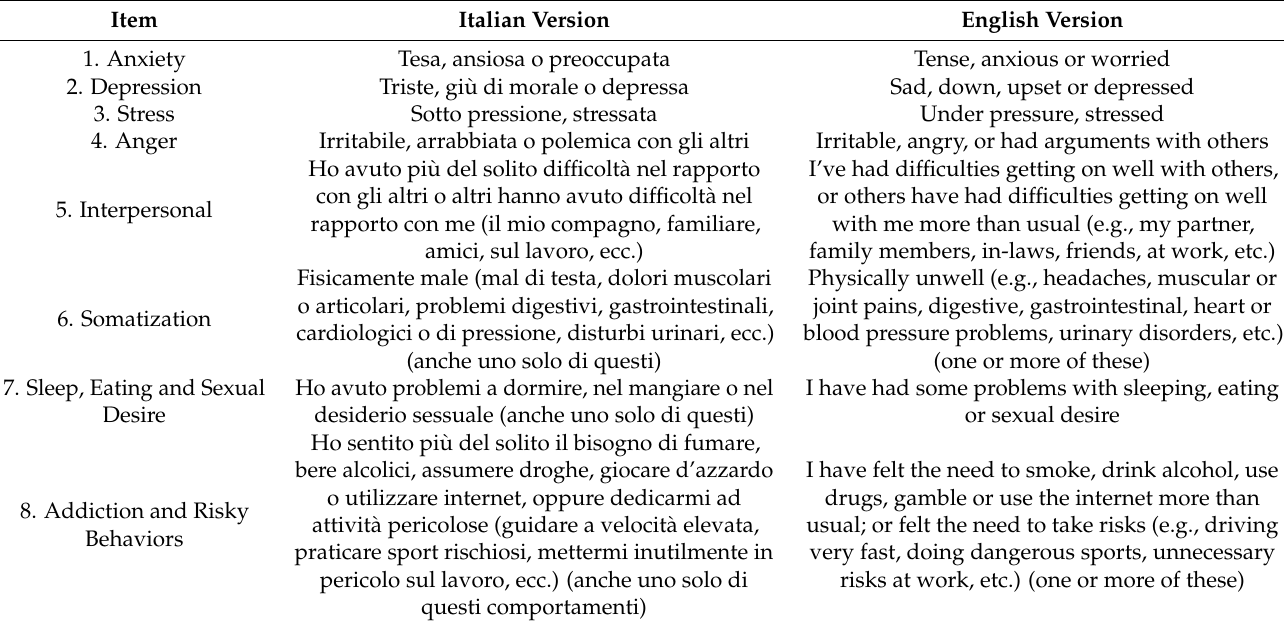
Table 1. The Perinatal Assessment of Maternal Affectivity